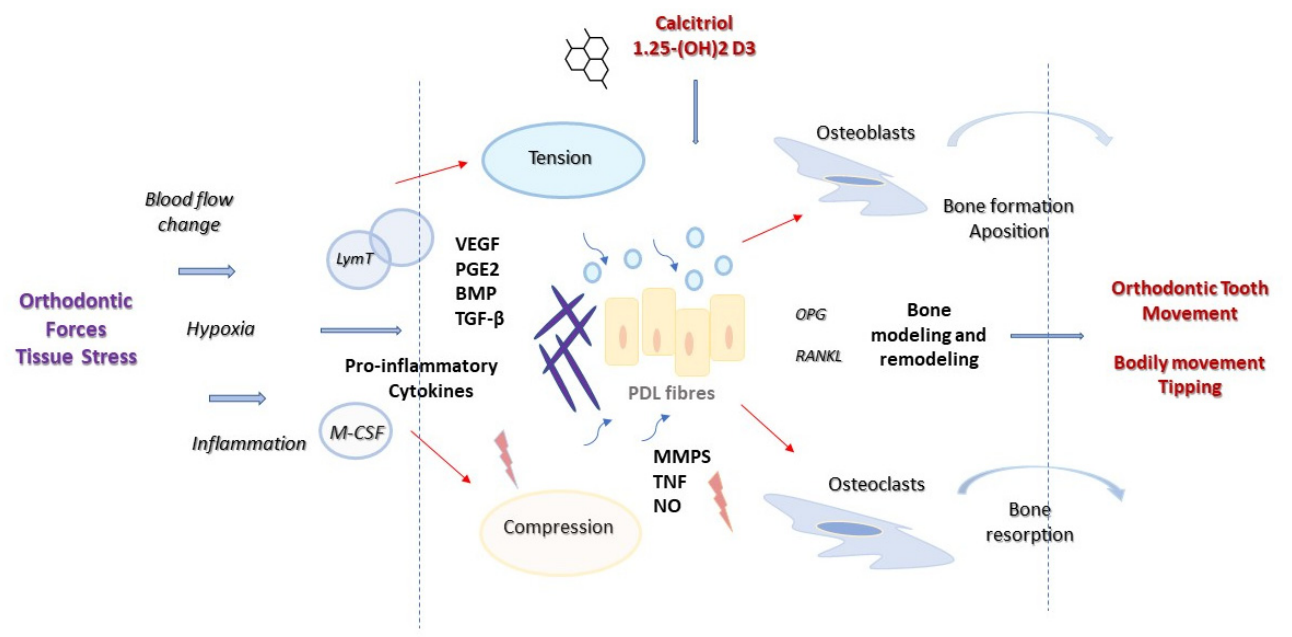
Figure 1. The potential acceleration of orthodontic tooth movement. The mechanism of CTL biological effect.